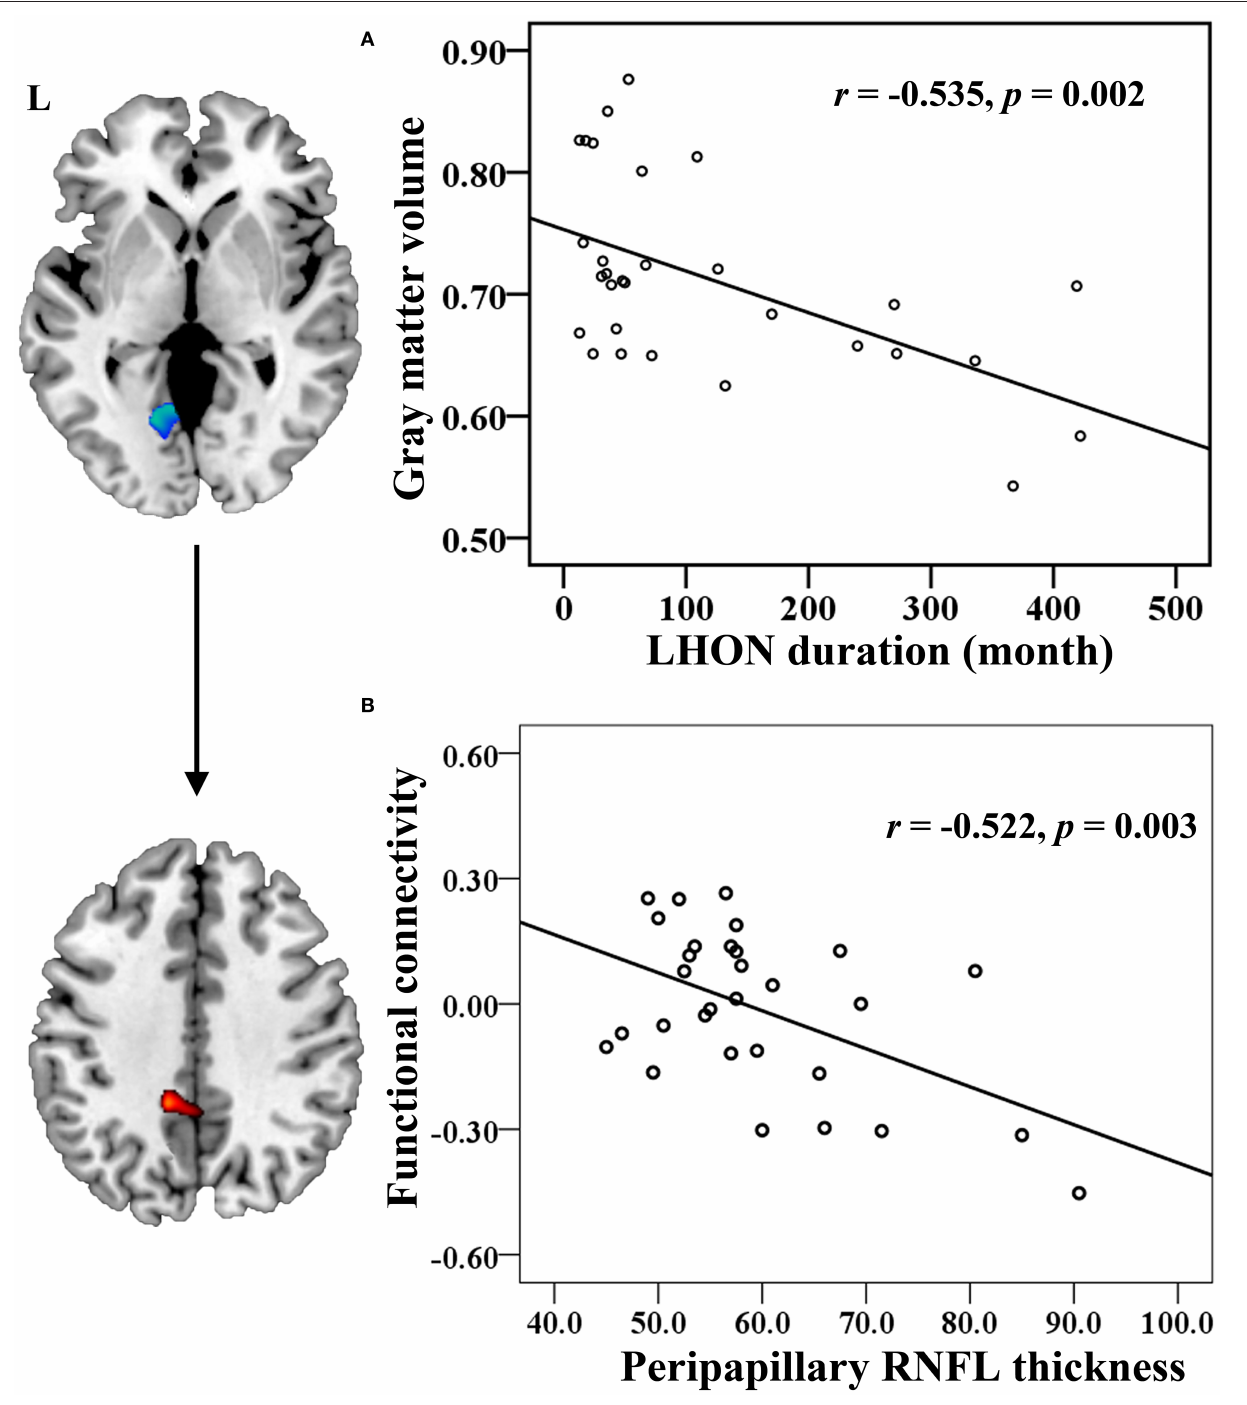
FIGURE 3 | Correlation between the neuroimaging findings and clinical measures in the chronic LHON. (A) Spearman correlation coefficient was used to test the association between LHON duration and GMV of left CG, and (B) Pearson correlation coefficient was used to test that between peripapillary RNFL thickness and FC between the left CG and left PCC ( p < 0.05, Bonferroni correction). CG, calcarine gyrus; FC, functional connectivity; GMV, gray matter volume; LHON, Leber’s hereditary optic neuropathy; PCC, posterior cingulate cortex; RNFL, retinal nerve fiber layer. individuals with congenital cataracts (Guerreiro et al., 2016), and between the PCC and visual cortex in chronic LHON may be limited recovery of the visual function in sight-restored subjects considered an indicator for the restoration of functional plasticity ( Fine et al., 2003; McKyton et al., 2015). The enhanced FC after